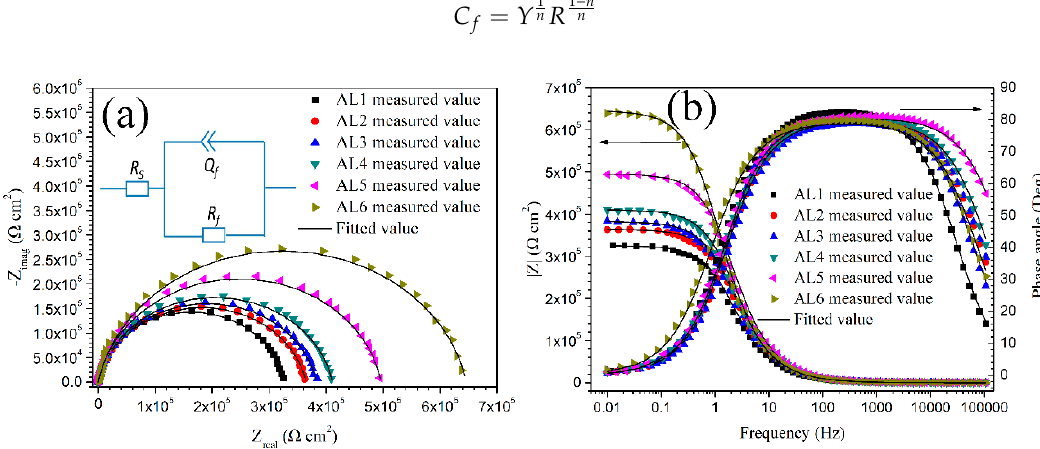
Figure 9. Typical electrochemical impedance spectroscopy (EIS) results of sintered 7075 alloys after 6 h immersion in 0.2 M Na 2 SO 4 + 0.01 M NaCl solution, ( a ) Nyquist plots, ( b ) Bode plots; equivalent circuit used to fit the EIS data is shown in ( a ), R s is solution resistance, R f is passive film resistance, and Q f is associated with passive film capacitance.